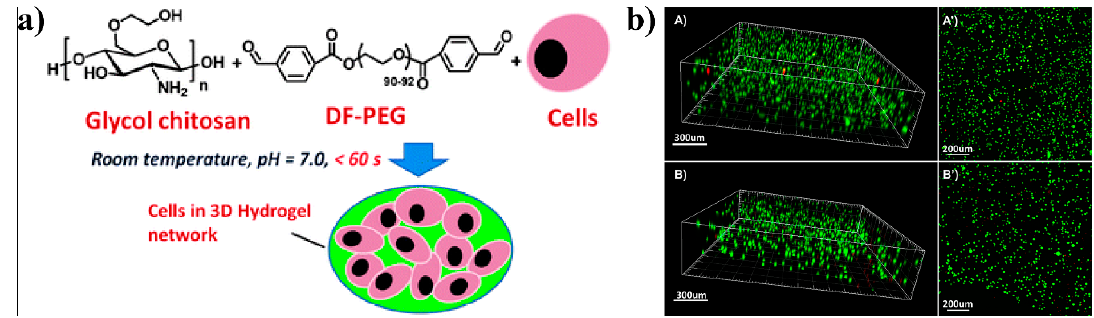
Figure 4. ( a ) Preparation of cells encapsulated in GC/DF PEG hydrogels under physical conditions; and ( b ) cell viability (viable cells: green; dead cells: red) and spatial distribution of Hela cells embedded in the hydrogel after 24 h and 72 h. Reprinted with permission [39]. Copyright 2012, Royal Society of Chemistry.